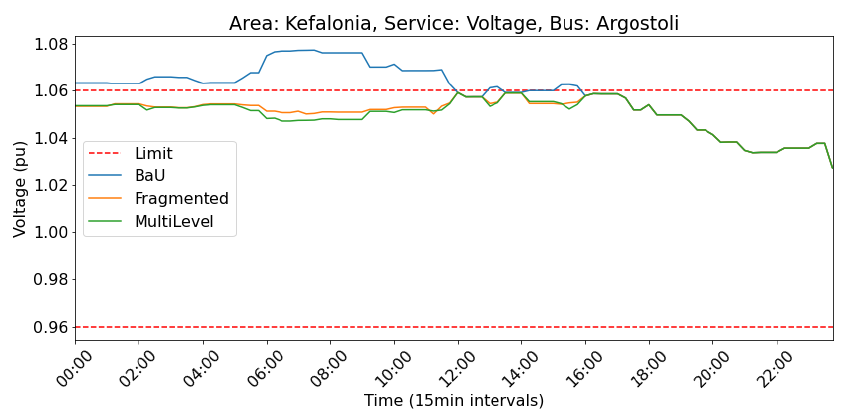
Figure 6. Example of a daily voltage variation at Argostoli substation during springtime.